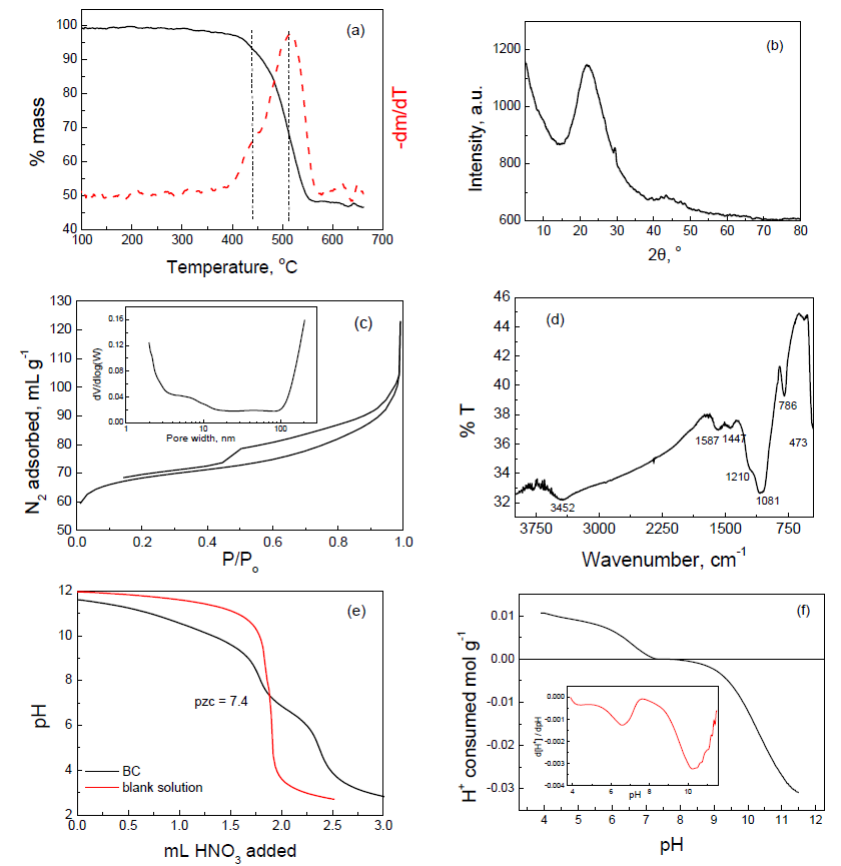
Figure 2. Physicochemical characterization of RHB700: ( a ) TGA curves under an air atmosphere with 20 mL min −1 flow and 10 °C min −1 heating rate; ( b ) XRD pattern; ( c ) N 2 adsorption – desorption isotherms with inset showing pore size distribution; ( d ) FTIR spectrum recorded in 1% w/w biochar in KBr pellet; ( e ) potentiometric mass titrations curve for the biochar and the corresponding curve for the blank solution; ( f ) the H + consumption by the surface as pH function with inset showing the differential curve of the H + consumed with pH, where the inverse peaks denote the surface